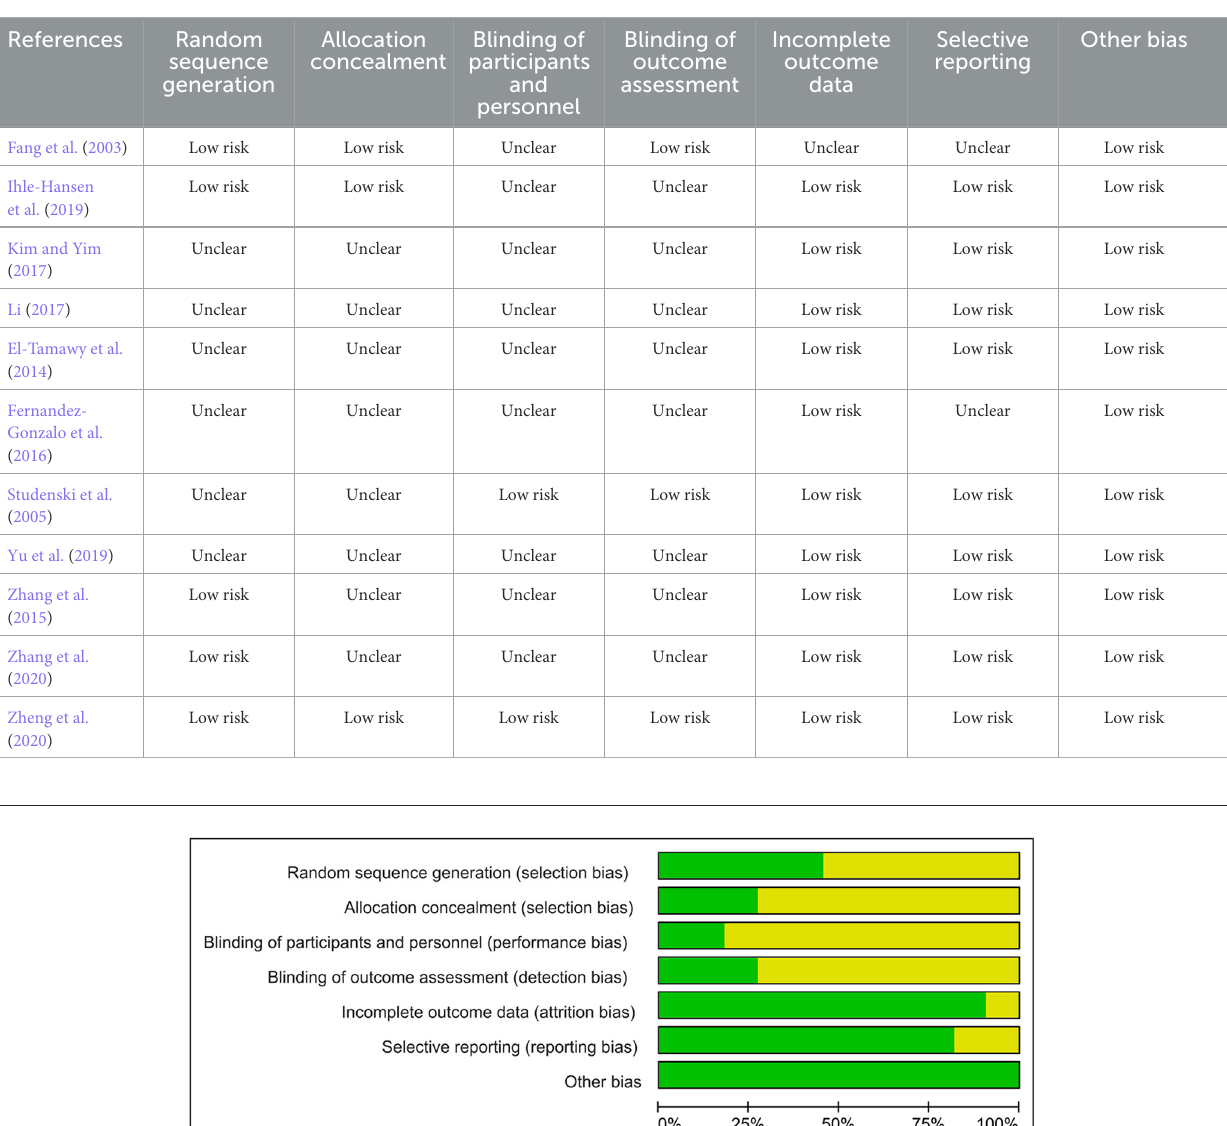
TABLE 2 Quality evaluation of the included literature.